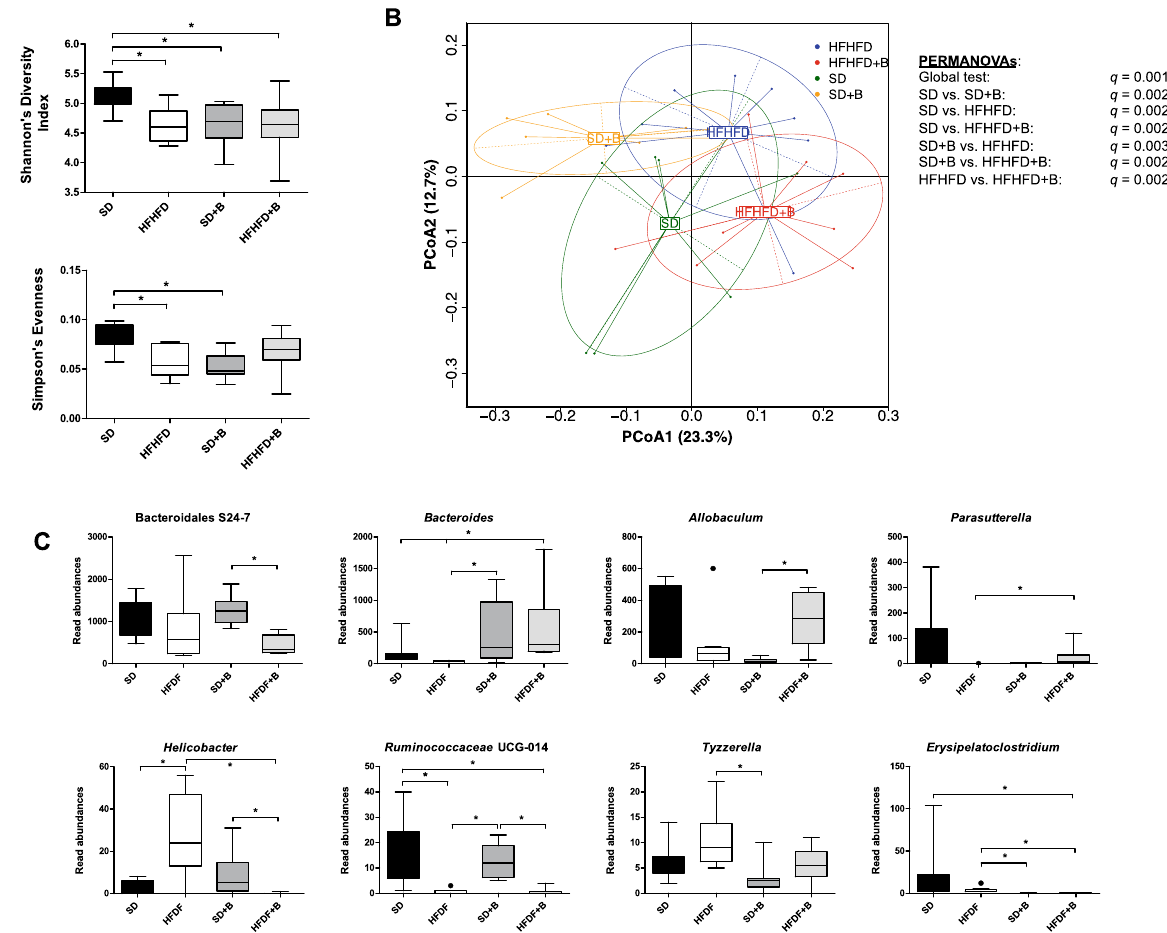
Figure 4. ( A ) Alpha diversity indices (Shannon’s diversity index, Simpson’s index, Simpson’s reciprocal index and Simpson’s evenness) from each treatment group. ( B ) Principle coordinates analysis (PCoA) plot using generalized UniFrac distances comparing microbial communities from each treatment group. Group means are indicated by the center of each ellipse. Distance-based non-parametric PERMANOVA tests were conducted at a global level as well as pairwise comparisons of treatment groups. p values of all pairwise comparisons were corrected for multiple comparisons (q) using false discovery rate. ( C ) Boxplots of gut microbiota taxonomic groups that demonstrated significant differences between treatment groups. Significant differences ( p < 0.05) between treatment groups are represented with